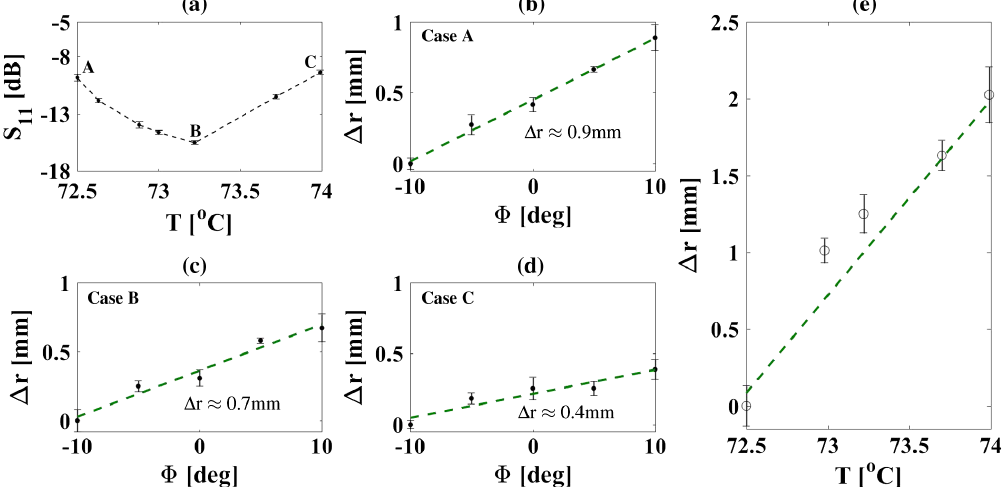
FIG. 11. Measured kick dependencies on gun phase and frequency detuning (or cavity temperature). Green lines: linear fits to the data. Φ : gun phase with respect to MMMG. The insets Δ r represent peak to peak changes.